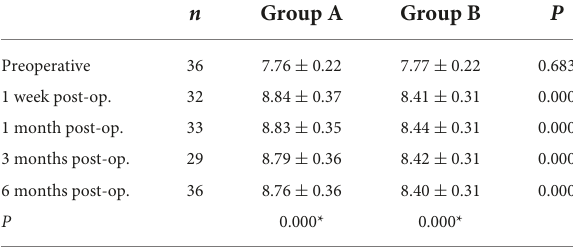
TABLE 3 Anterior corneal radius of curvature of the 3 mm area at the center of the thinnest point of the cornea